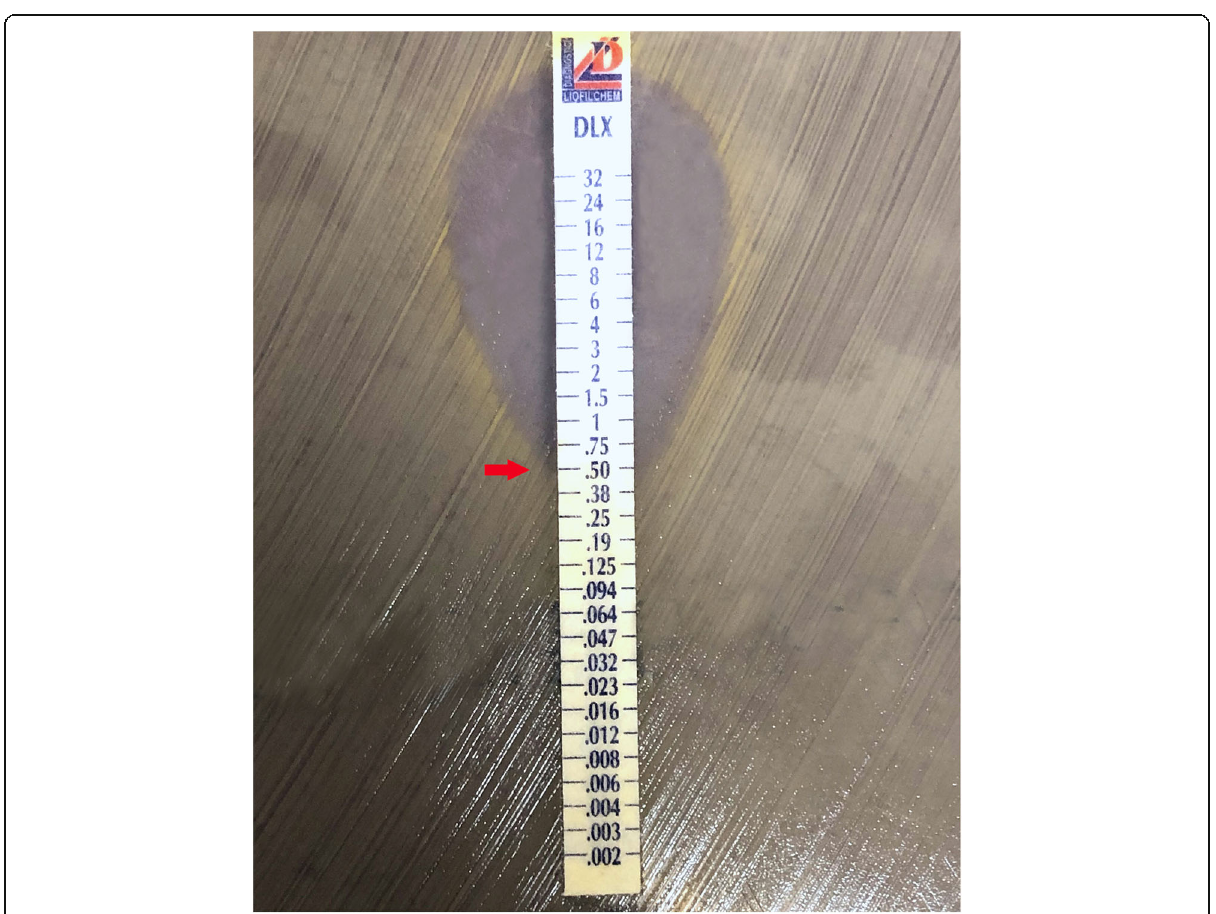
Fig. 1 Growth of Gram-positive organisms from intravitreal endophthalmitis isolates on Mueller-Hinton agar with ETEST strip testing for antibiotic susceptibilities and minimum inhibitory concentrations. The drug is eluted in immediate proximity to the plastic carrier, creating a gradient of drug concentrations to measure the minimum concentration required for the inhibition of growth. This figure represents inhibition of growth (red arrow), a minimum concentration of 0.5 μ